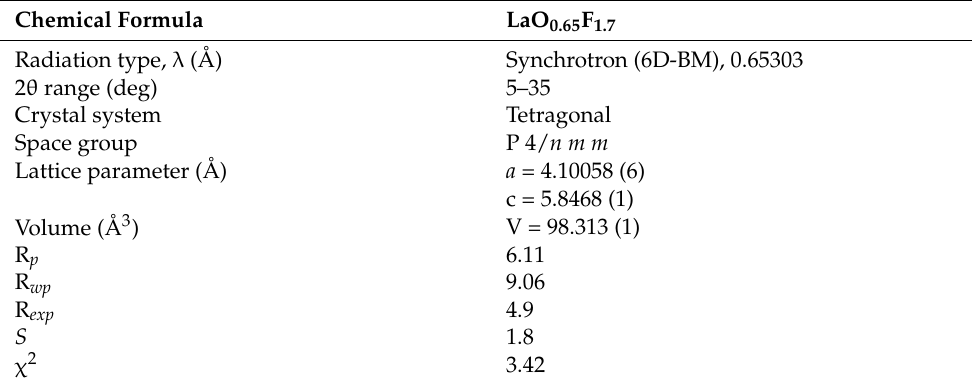
Figure 1. Synchrotron XRD pattern of a tetragonal LaO 0.65 F 1.7 sample. Table 1. Rietveld refinement and crystal data of a LaO 0.65 F 1.7 structure.